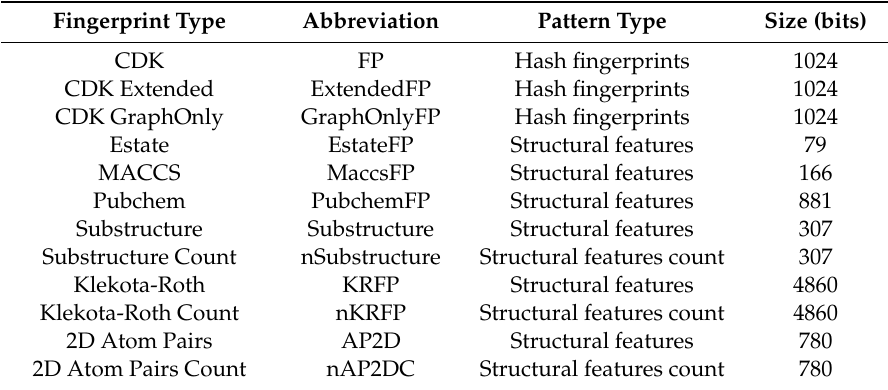
Table 6. Summary of the 12 Types of Molecular